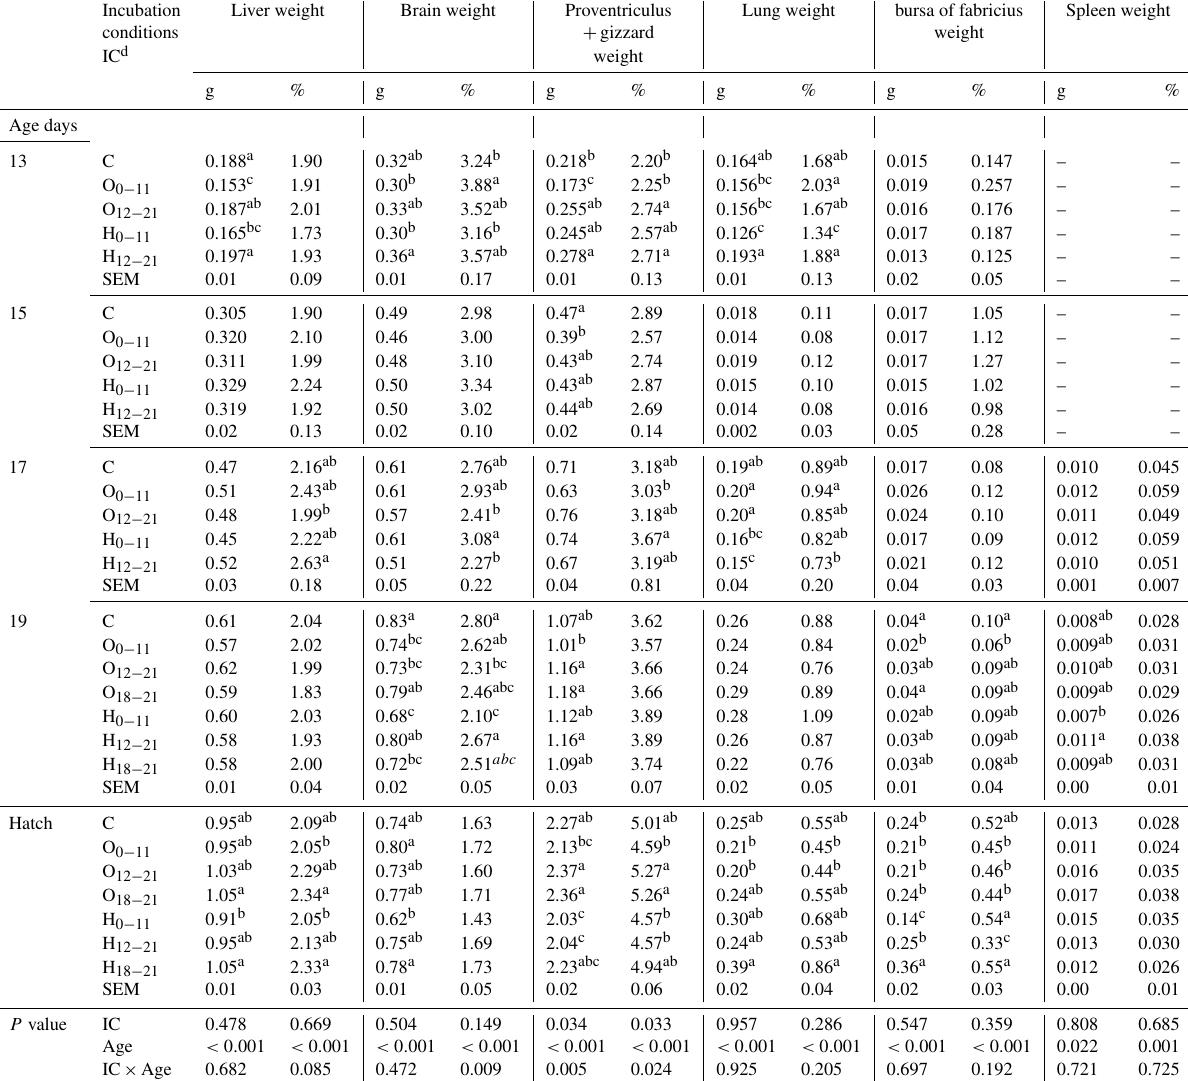
Table 5. Effects of incubation conditions and embryo age (at days 13, 15, 17, 19, and 21 of embryo development) on weights of liver (g, %), brain (g, %), proventriculus and gizzard (g, %), lung (g, %), bursa of fabricius (g, %), and spleen (g, %) induced by hypoxia at high